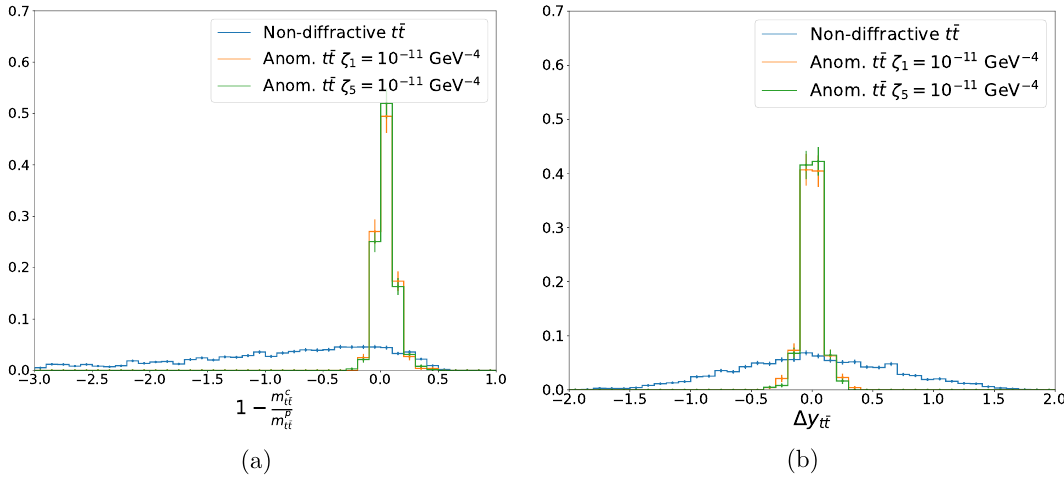
Figure 8. Mass match ratio (a) and rapidity difference (b) between the t ¯ t reconstructed from its decay products and from tagged protons. Events passing both pre-selection and central selection are shown. Histograms are normalized to unity.